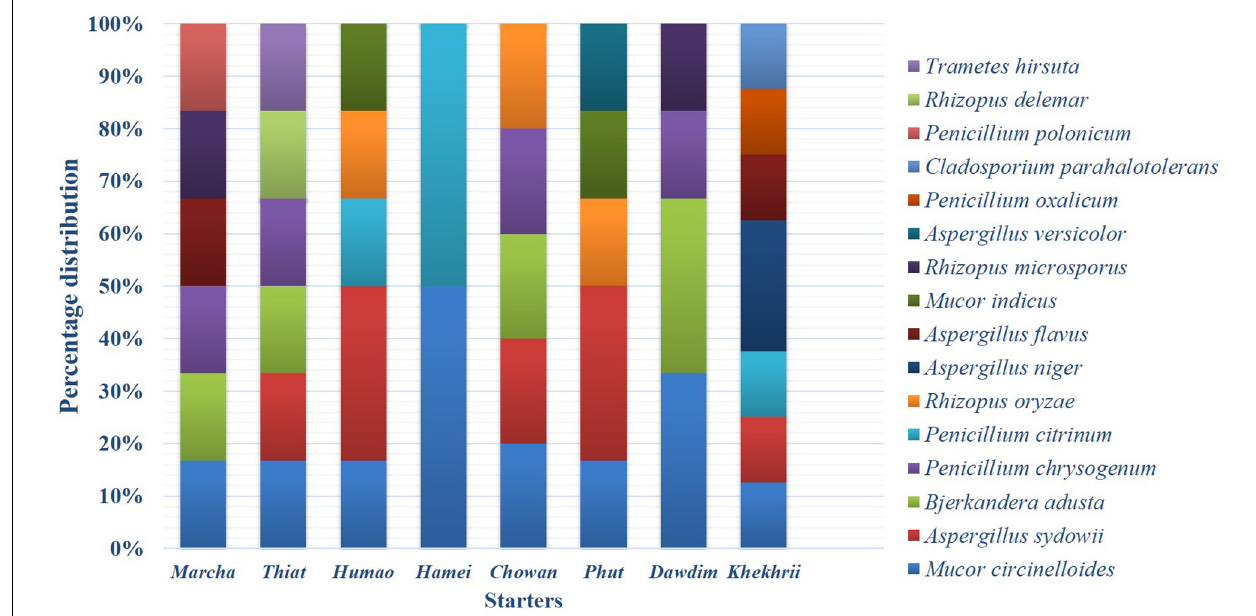
FIGURE 4 | Abundance distribution of the filamentous fungi isolated from dry starters from North East